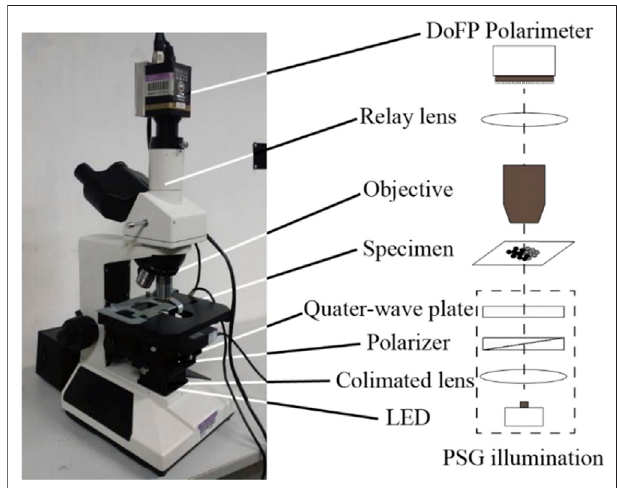
FIGURE 2 | Polarization microscope based on division-of-focal plane (DoFP) polarimeter (Chang et al., 2016).